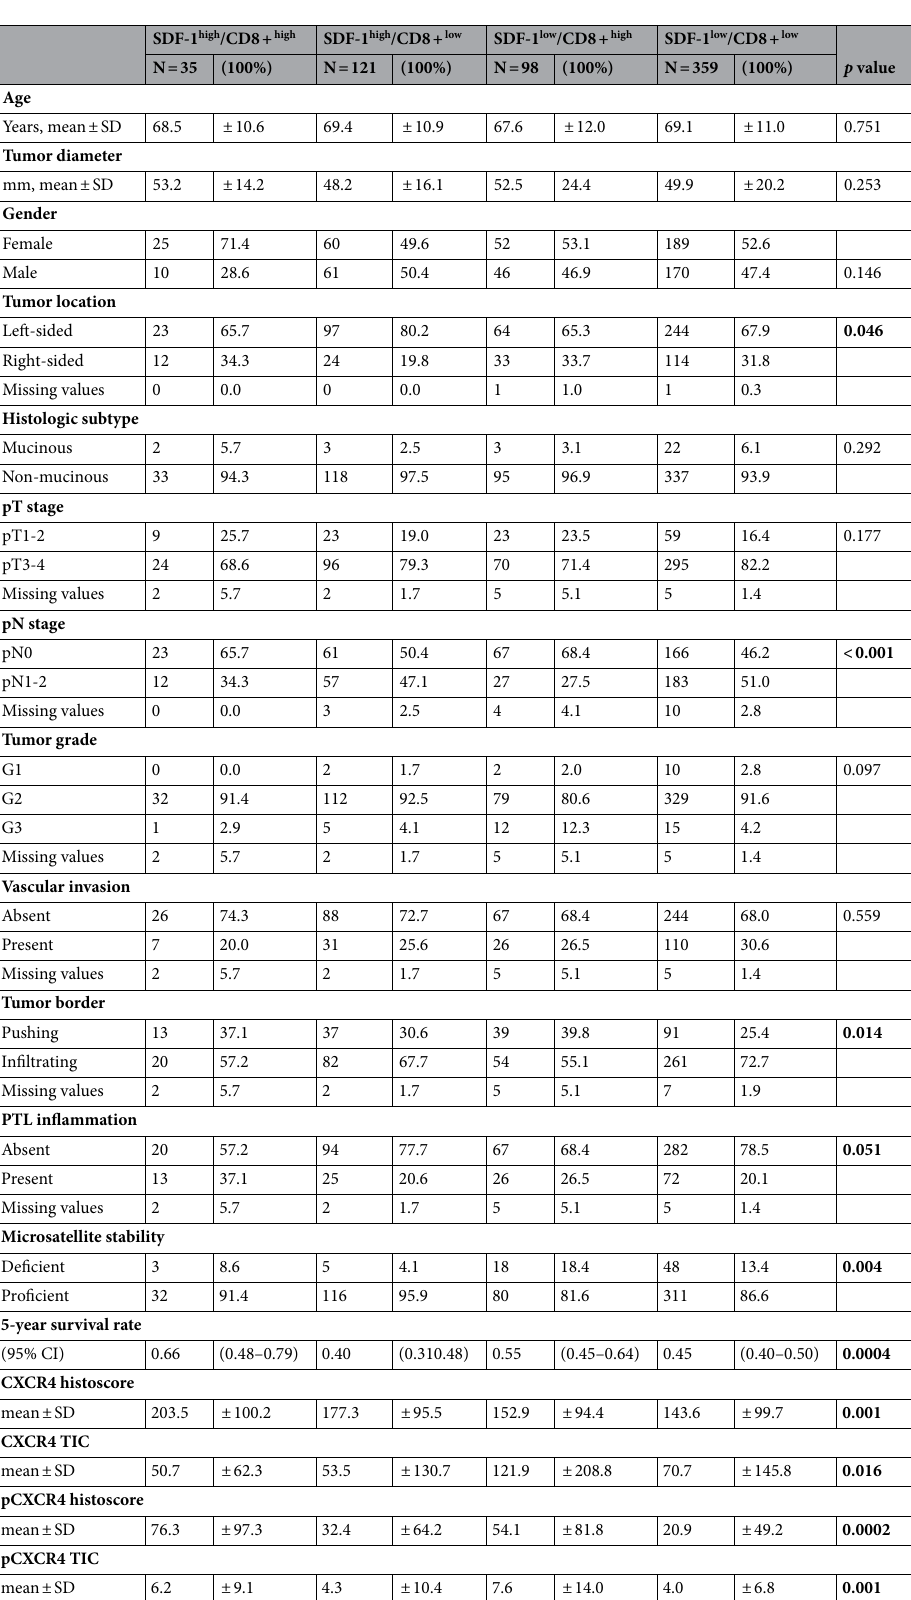
Table 2. Association of SDF-1 + tumor expression and CD8+ low and high immune cell density with clinicopathological features in CRC (n = 613). Variables are indicated as absolute numbers, %, median or range; age and tumor size were evaluated using the Kruskal–Wallis test. Gender, anatomical site, T stage, N stage, grade, vascular invasion, and tumor border configuration were analyzed using the χ 2 test. Survival analysis was performed using the Kaplan–Meier method. Significant p values are